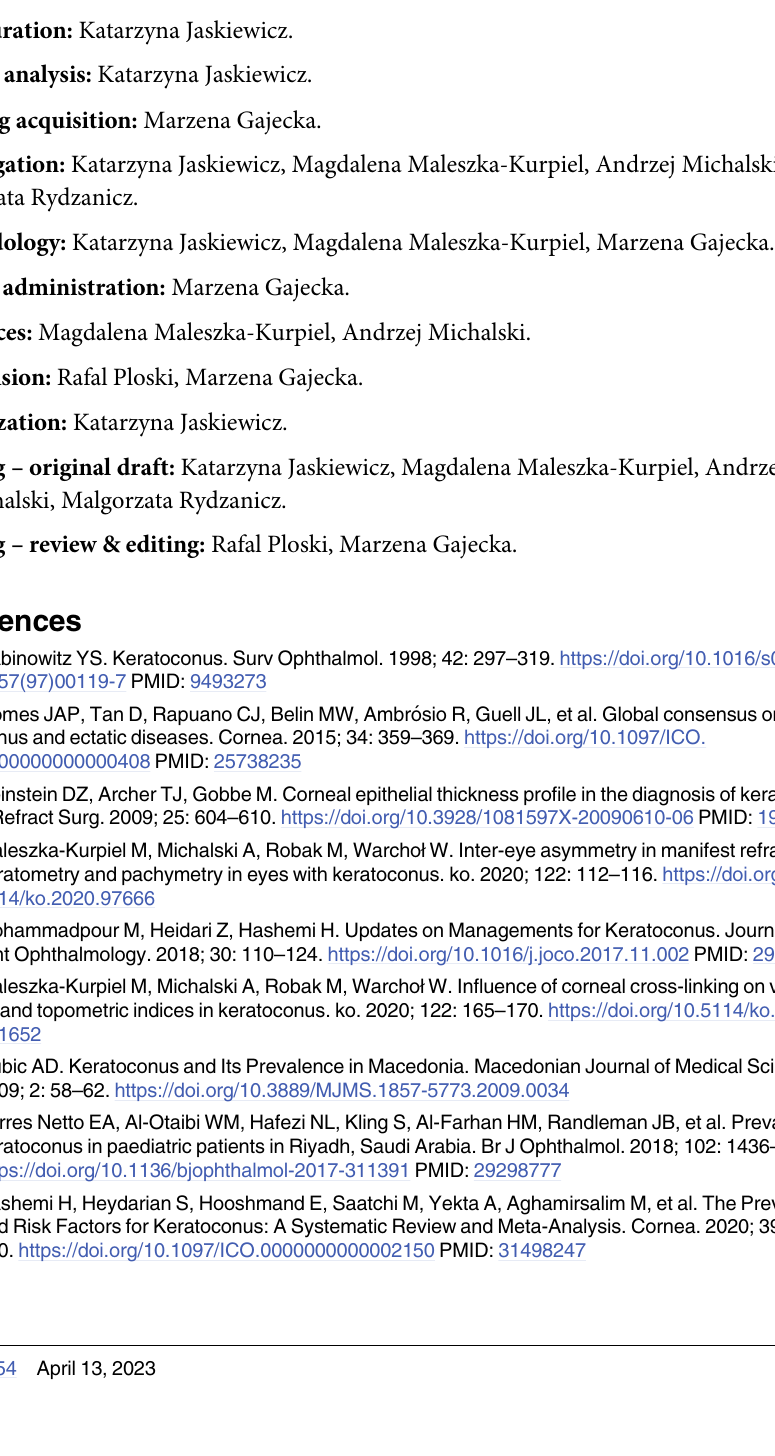
S8 Table. STROBE